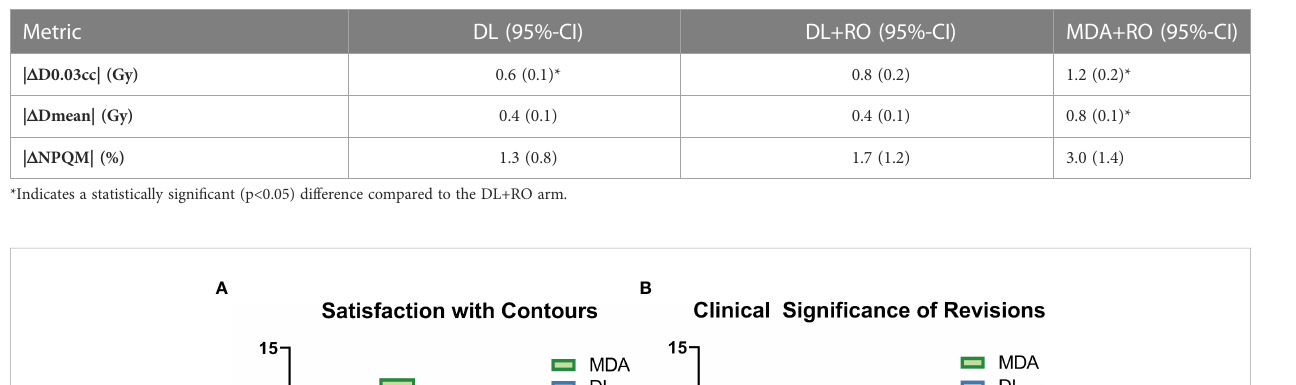
TABLE 4 Mean agreement with gold standard using dosimetric comparisons.